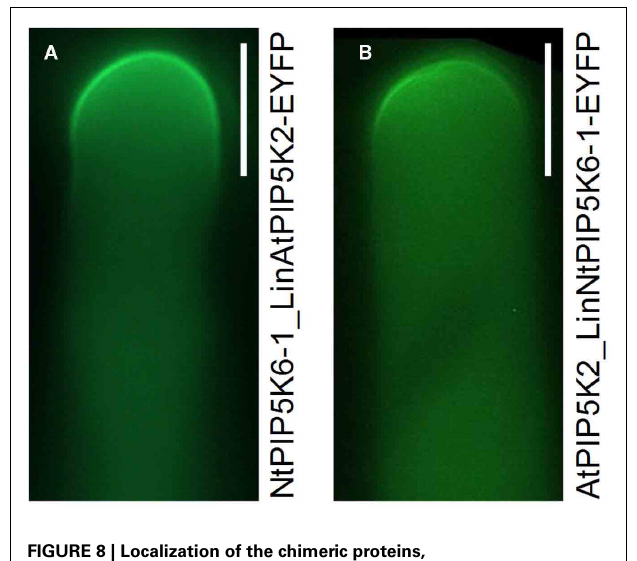
FIGURE 8 | Localization of the chimeric proteins, NtPIP5K6-1_LinAtPIP5K2-EYFP andAtPIP5K2_LinNtPIP5K6-1-EYFP in tobacco pollen tubes. The chimeric enzymes were overexpressed in tobacco pollen tubes as fusions to C-terminal EYFP-tags and the fluorescence distribution was monitored. (A) , NtPIP5K6-1_ LinAtPIP5K2-EYFP; (B) , AtPIP5K2_LinNtPIP5K6-1-EYFP. Images are taken from experiments shown in Figure 7 and are representative for ≥ 300 transgenic pollen tubes observed for each construct. Bars, 10 μ m.